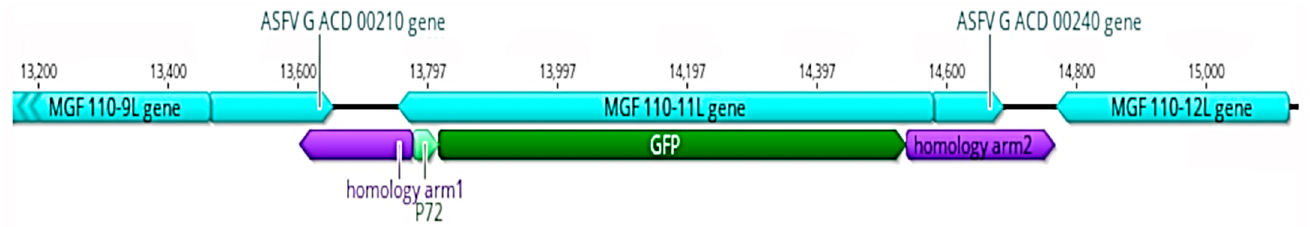
Figure 1. Schematic representation of the construction of MGF 110-11l deletion mutant. 760 bp of the 825 bp of the MGF 110-11L gene were replaced by the p72 promoter-controlled eGFP reporter gene.